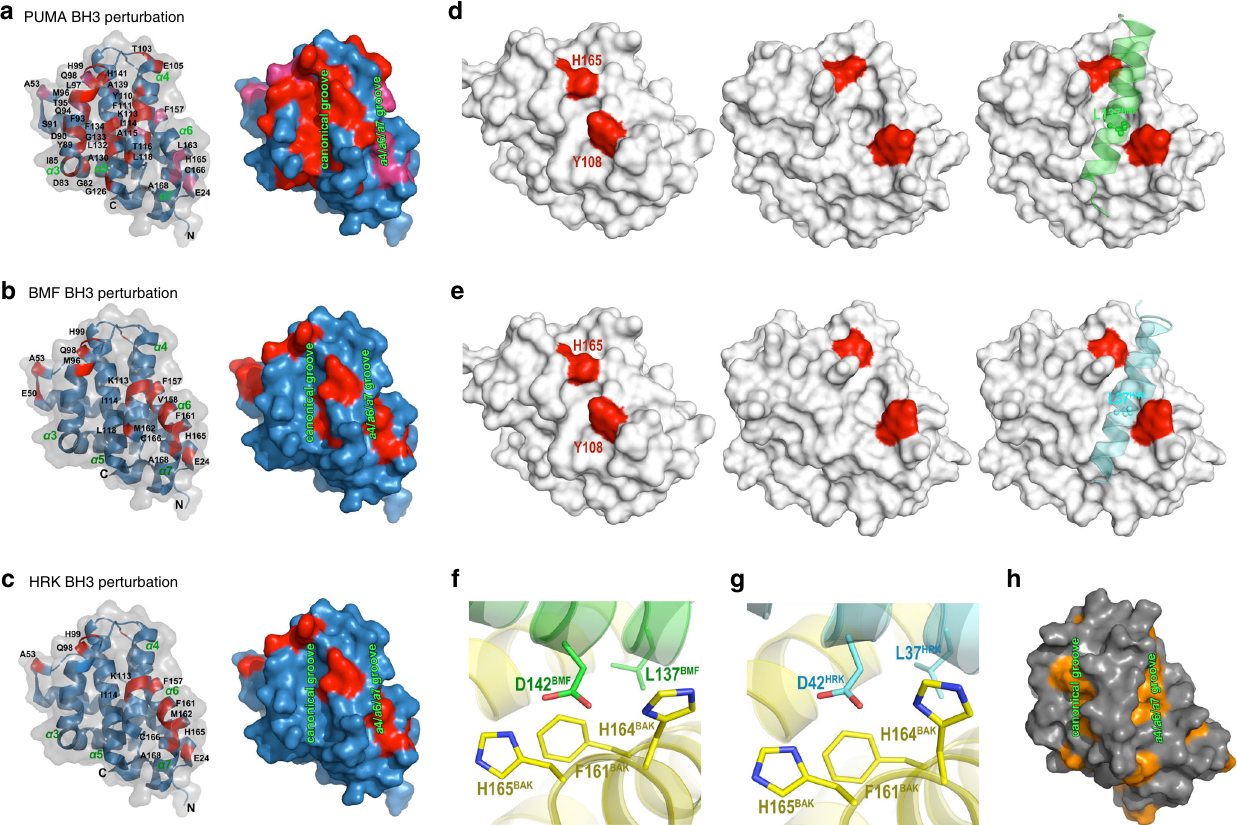
Fig. 5 BMF and HRK BH3 domains perturb residues that differ from PUMA BH3. a – c Surface and cartoon mixed model (left) or surface model (right) of BAK (PDB:2IMS) showing residues (indicated in red) that have obvious chemical shift changes or disappearance of signals (peak intensities decreased to the level of noise) on the 1 H, 15 N-HSQC spectra after the perturbations by PUMA BH3 a , BMF BH3 b , or HRK BH3 c . d , e Conformational change of Y108 and H165 residues on BAK induced by BMF BH3 d and HRK BH3 e to expose the α 4/ α 6/ α 7 groove. Left, before adding peptides; middle, after adding peptides; right, with peptides. f , g Close-up view of the primary intermolecular interactions of BAK with BMF BH3 f and HRK BH3 g . h Hydrophobic analysis of BAK was generated by Pymol with the overall structure displayed in gray and the hydrophobic surface displayed in